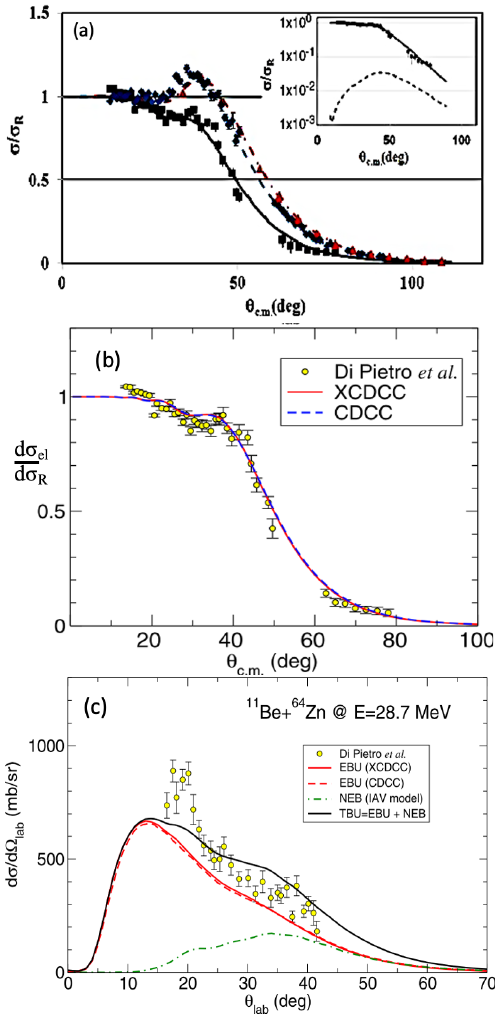
Fig. 8. (a) Angular distribution of the quasielastic cross sections for 11 Be + 64 Zn at E = 28.7 MeV [34] (black circles), and for the system 10,9 Be + 64 Zn at similar collision energy (blue and red squares). (b) CDCC and XCDCC calculations are compared with the experimental quasielastic cross section (yellow circles) [35]. (c) Angular distribution of the breakup cross sections (yellow circles). Various calculations are shown with solid, dashed and dotted lines; see text for